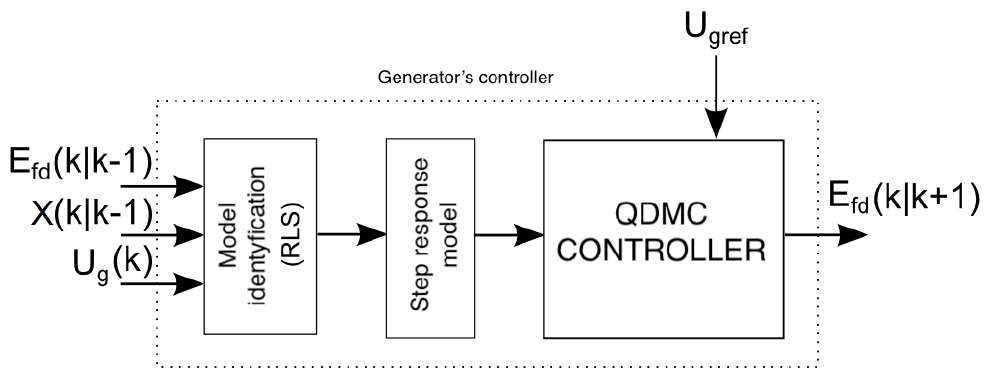
Figure 9. Model calculation for the generator QDMC controller